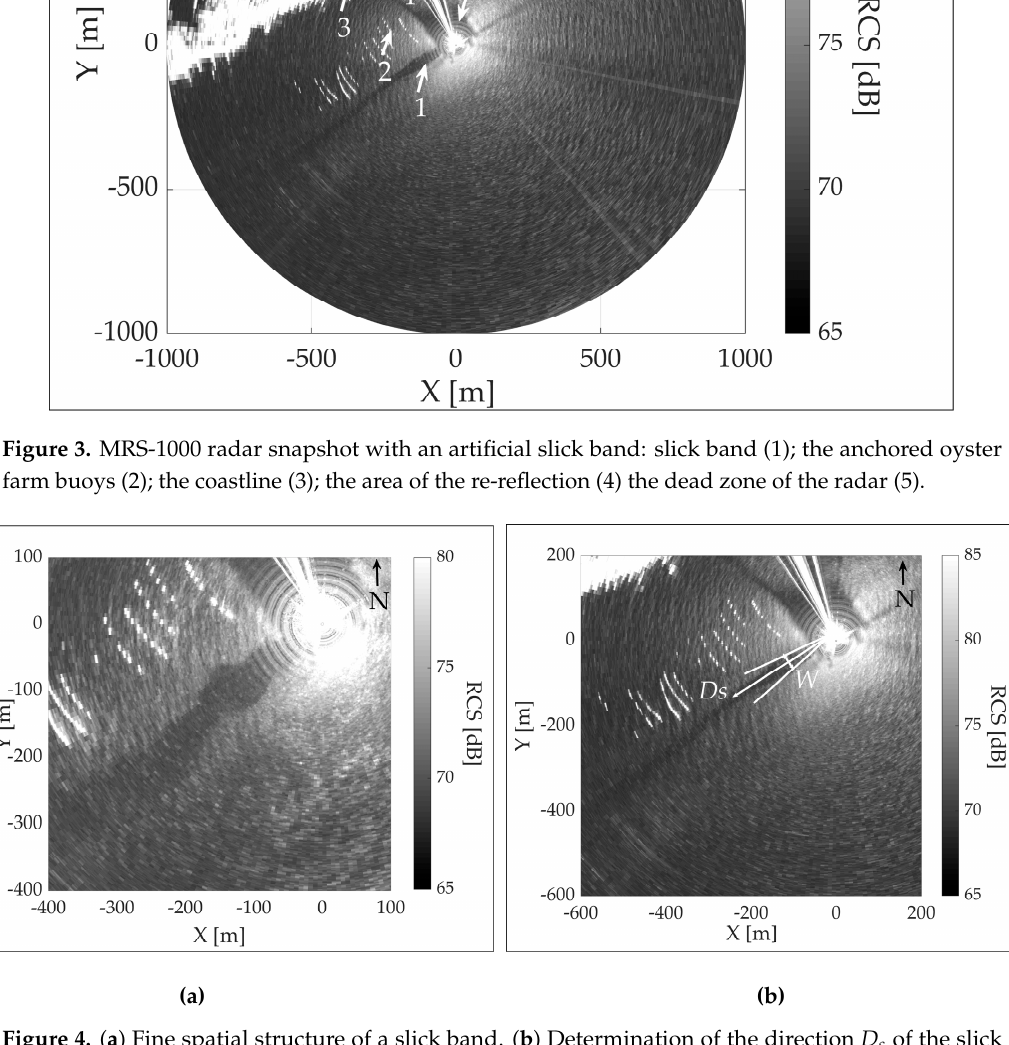
Figure 4. ( a ) Fine spatial structure of a slick band. ( b ) Determination of the direction D s of the slick band and its width W .